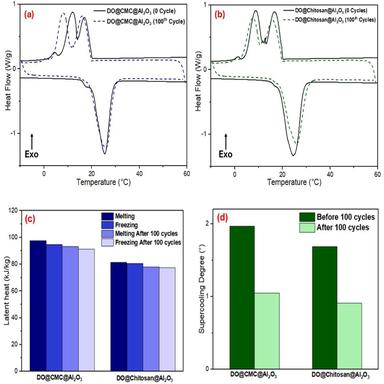
DSC curves before and after 100 heating/cooling cycles of EPCMs: (a) DO@CMC@Al2O3 and (b) DO@Chitosan@Al2O3. Effect of cycles on (c) latent heat and (d) supercooling degree.